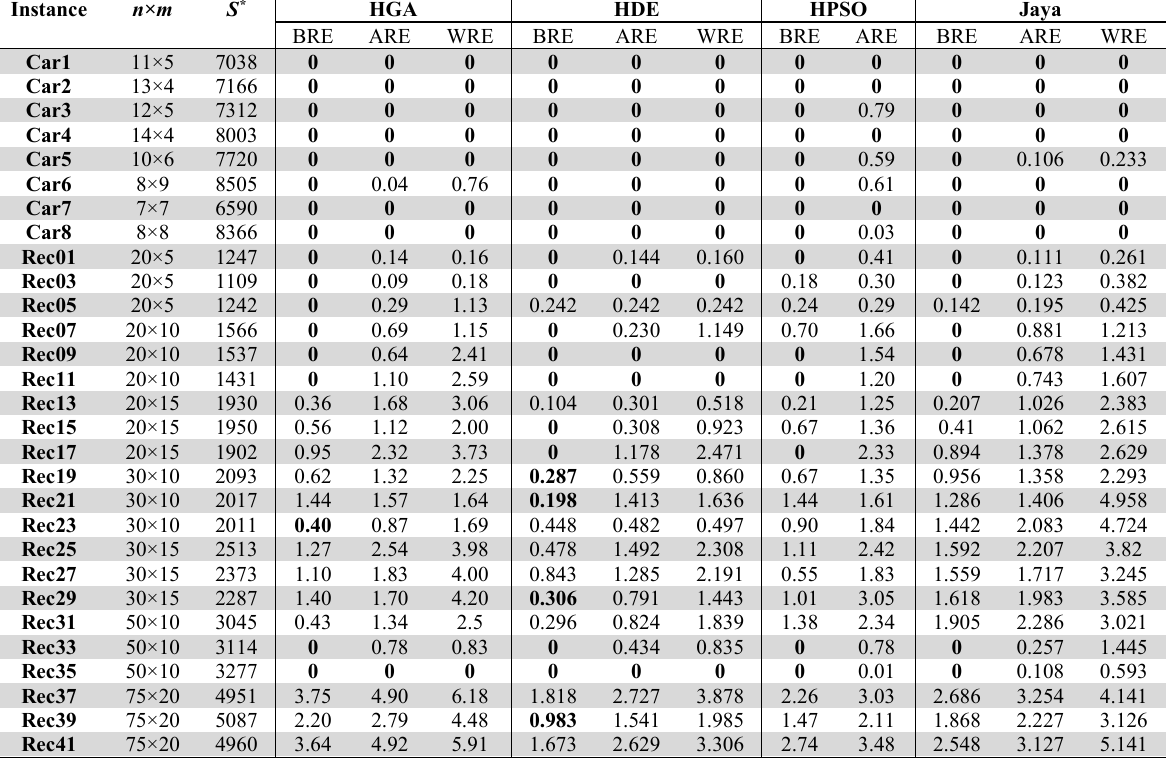
Comparisons of HGA, HDE, HPSO and Jaya. Bold indicate the best solution obtained among various